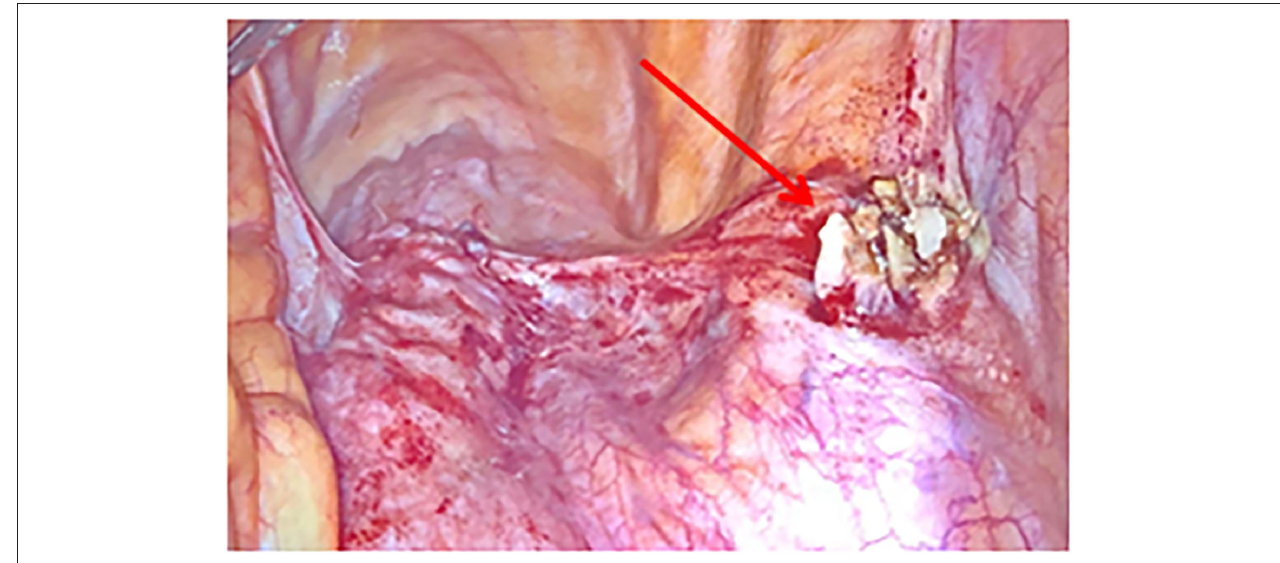
FIGURE 2 | Laparoscopic view: purulent collection involving the polypropylene mesh (arrow).